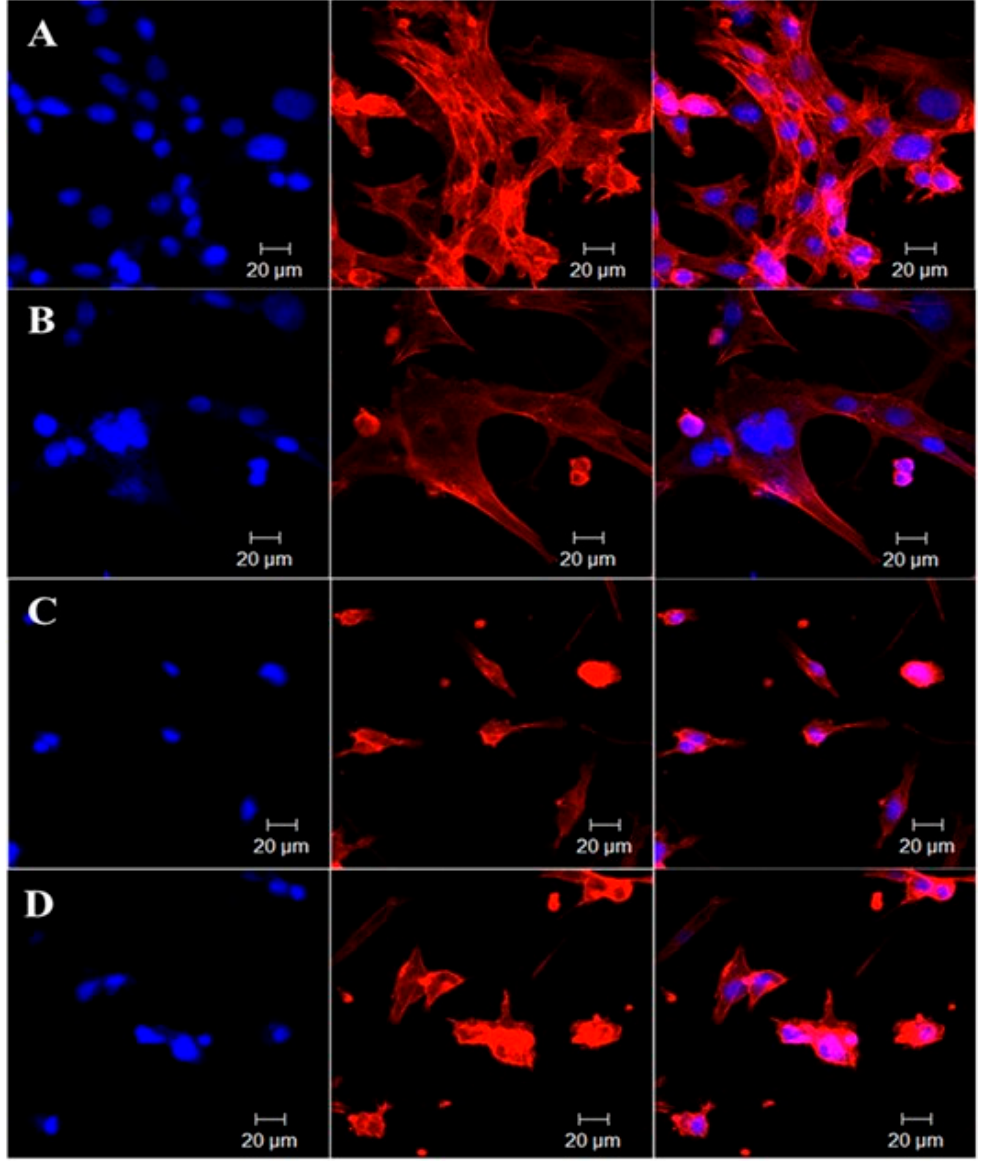
Figure 4. In vitro cytoskeletal imaging with rhodamine B displaying localized tumoricidal effects of ( A ) GO-IO (control); ( B ) GO-IO-MH; ( C ) GO-IO-DOX; and ( D ) GO-IO-DOX-MH. Image from [32].